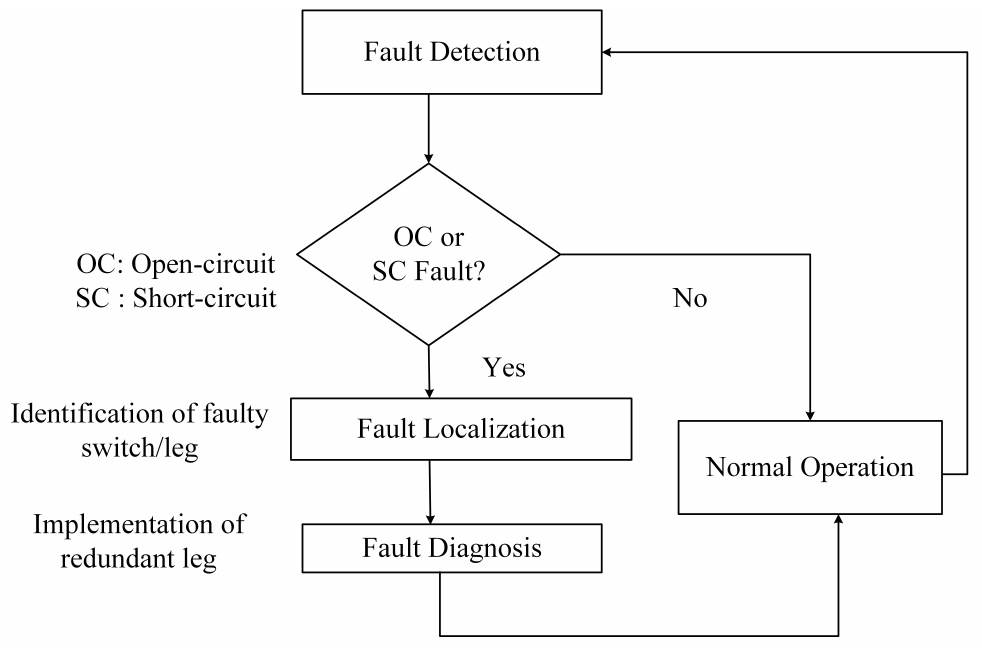
Figure 6. Flowchart of the Proposed fault-tolerant